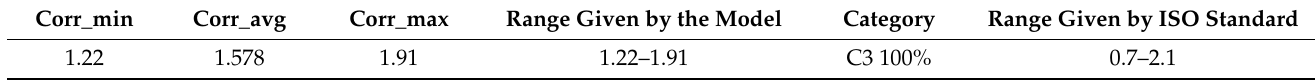
Table 5. Example of results for the case study.